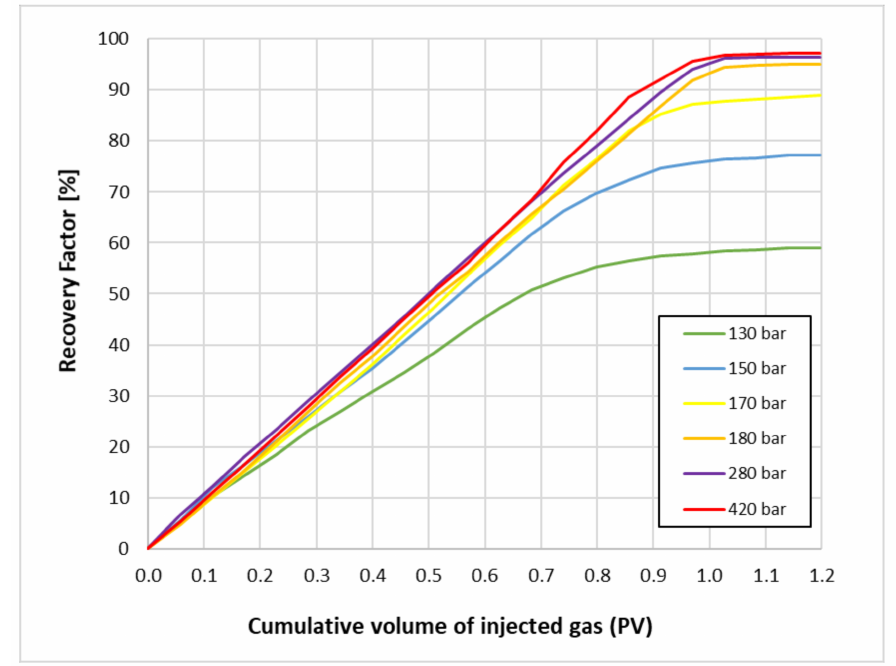
Figure 8. Overview of slim tube recovery factor curves for live oil and AG injected.